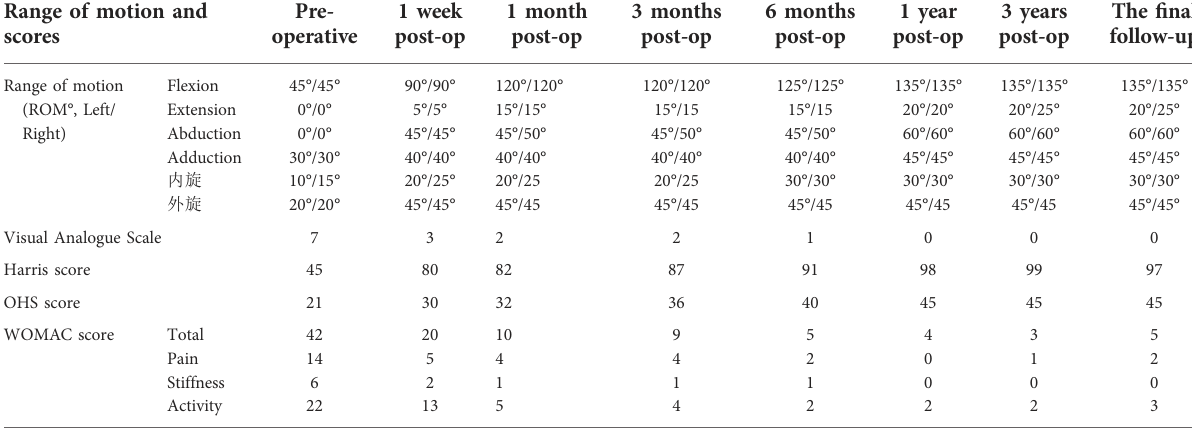
Table Note: Harris score and OHS score are hip-speci fi c scores, with a total score of 100 and 48, respectively. WOMAC quality of life score contains three aspects of pain, stiffness, and activity, and is divided into 24 subscales, with a total score of 96 points, from 0 to 4, in descending order of severity.